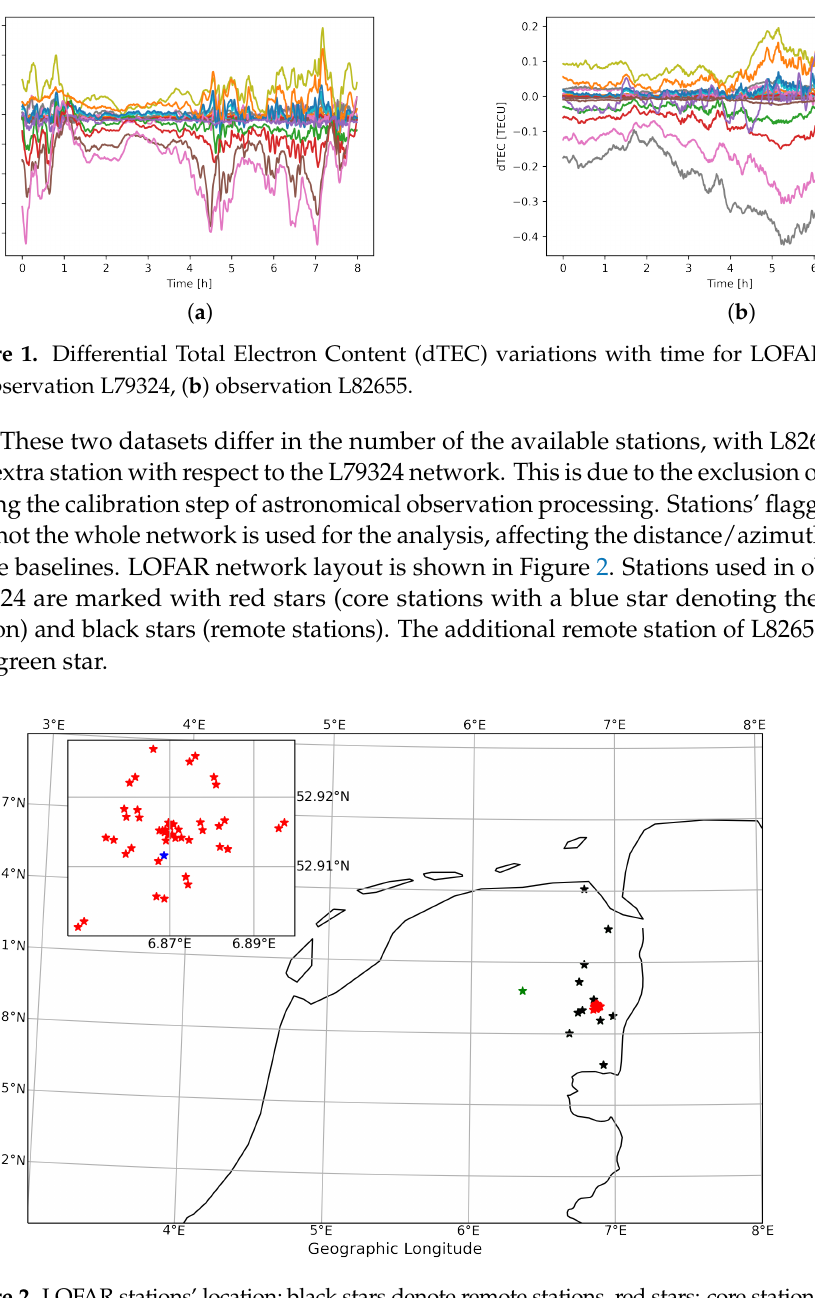
Figure 2. LOFAR stations’ location; black stars denote remote stations, red stars: core stations, green star: additional station of L82655 observation (see text). Blue star in the inset map shows the reference station. Wavelet